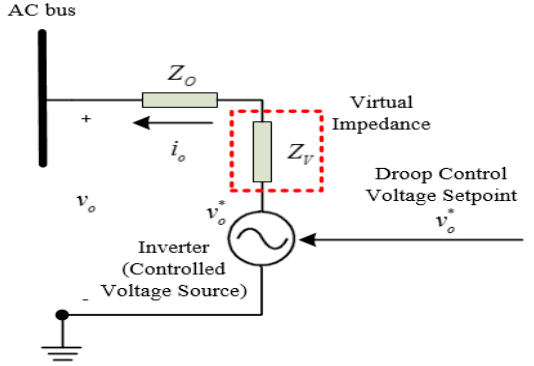
Figure 7 . Equivalent circuit after implementing the virtual impedance loop.